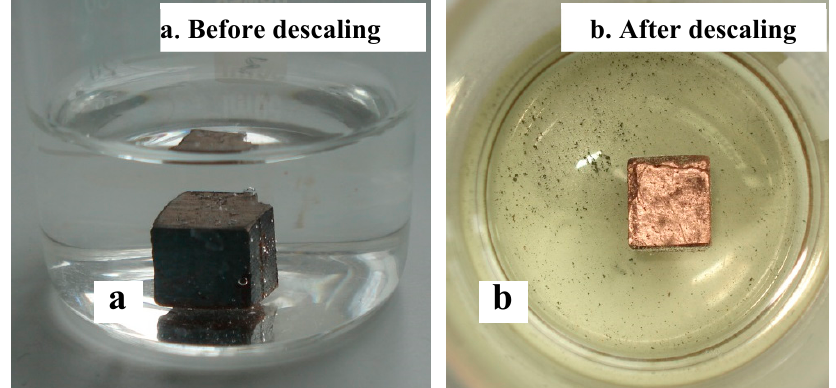
Figure 3. Macrographs of heated steel 2 before ( a ) and after ( b ) descaling in a beaker.